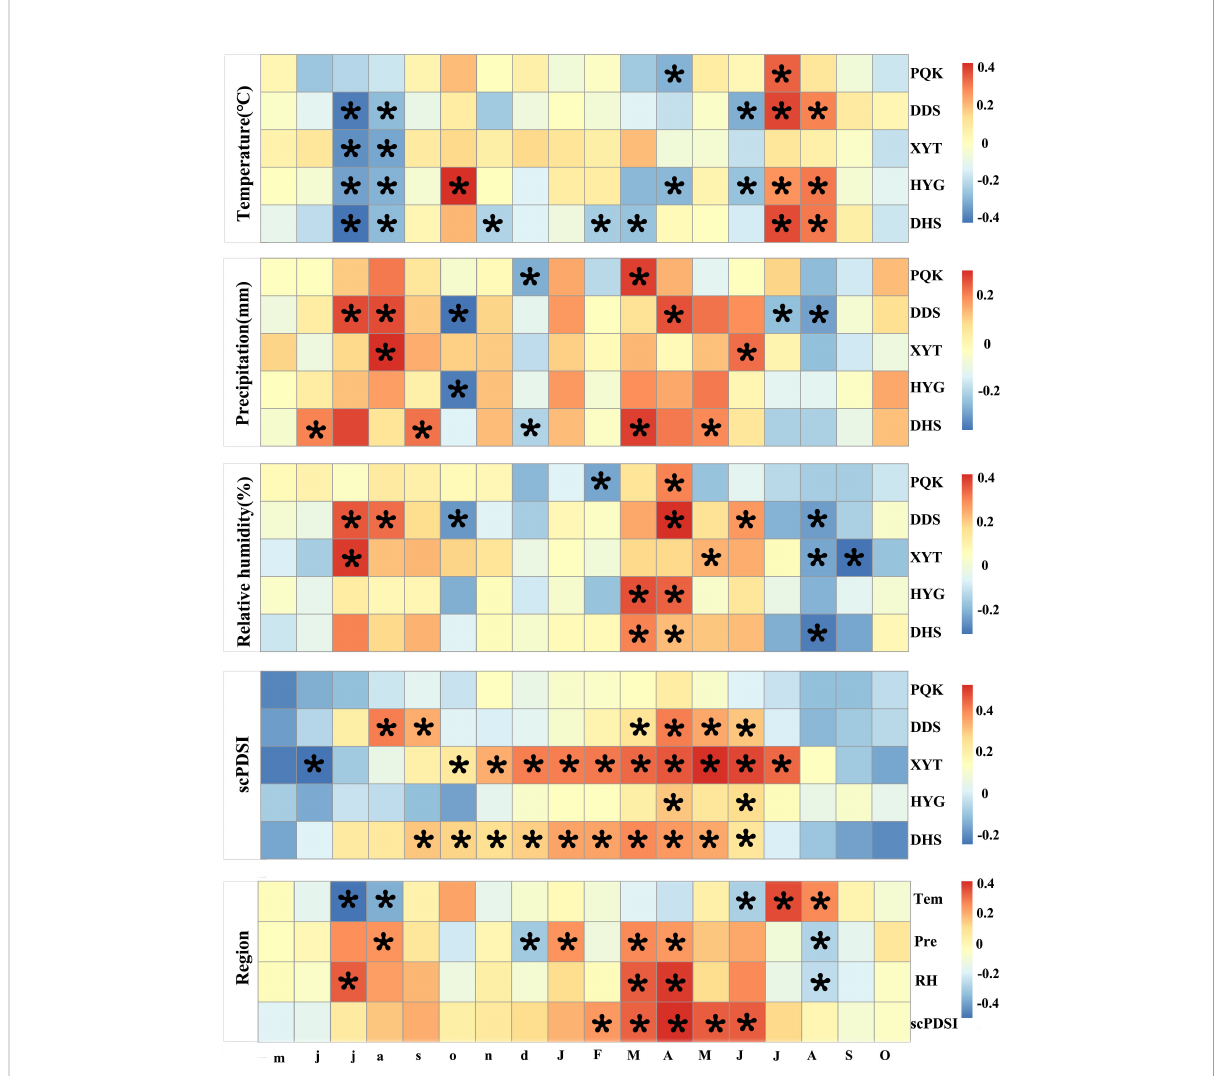
FIGURE 6 Correlations of the residual chronologies with fi rst-order differences of mean temperature, monthly precipitation, relative humidity and scPDSI from May of the previous year to October of the current year at the fi ve sampling sites and across the whole region (PQK, DDS, XYT, HYG, DHS) during 1961-2014. The previous year ’ s months are represented in lower case and those of the current year in upper case. Grid boxes with black stars indicate statistically signi fi cant results